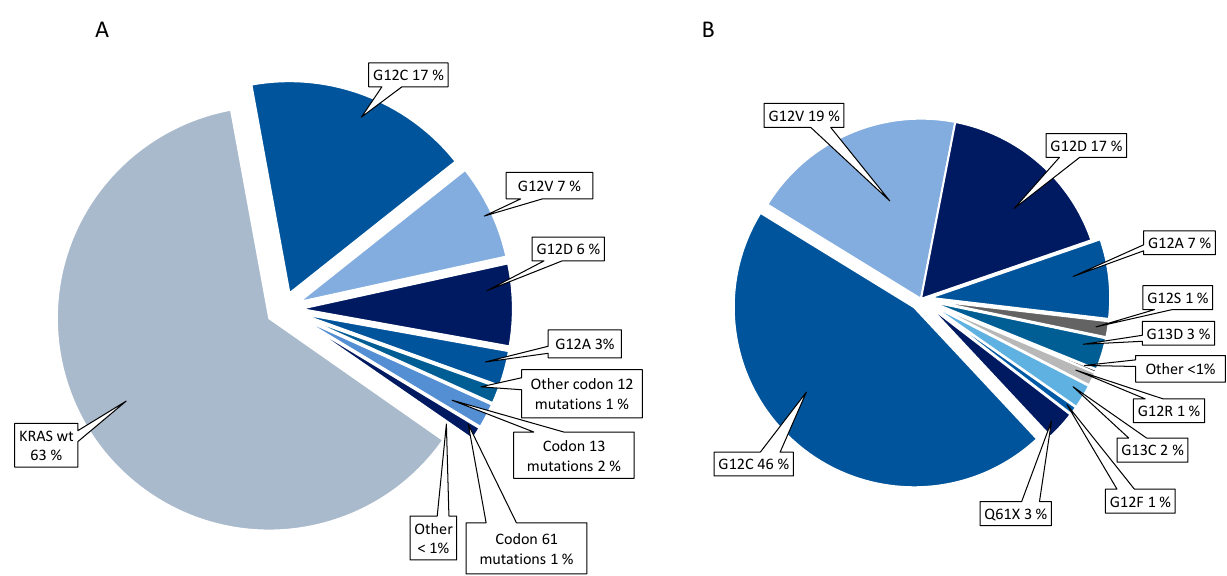
Figure 2. Frequencies of KRAS mutations in the whole cohort ( A ) and within the group of KRAS mutated patients ( B ).